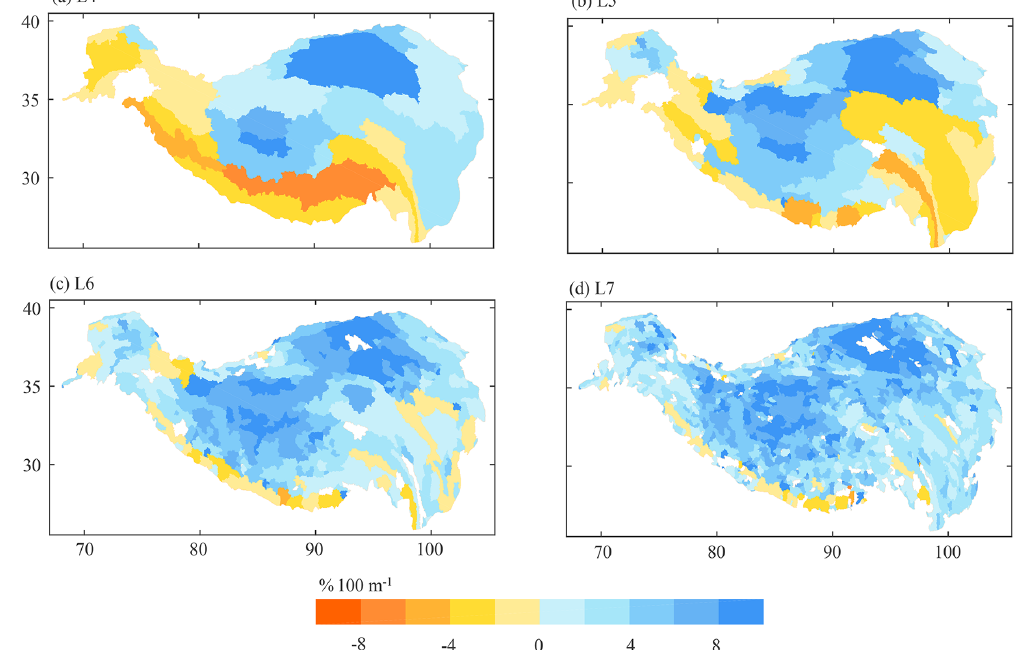
Figure 9. Spatial distribution of annual RPGs calculated at four sub-basin levels. The spatial scales of sub-basins (i.e. the sub-basin area) generally decrease from L4 to